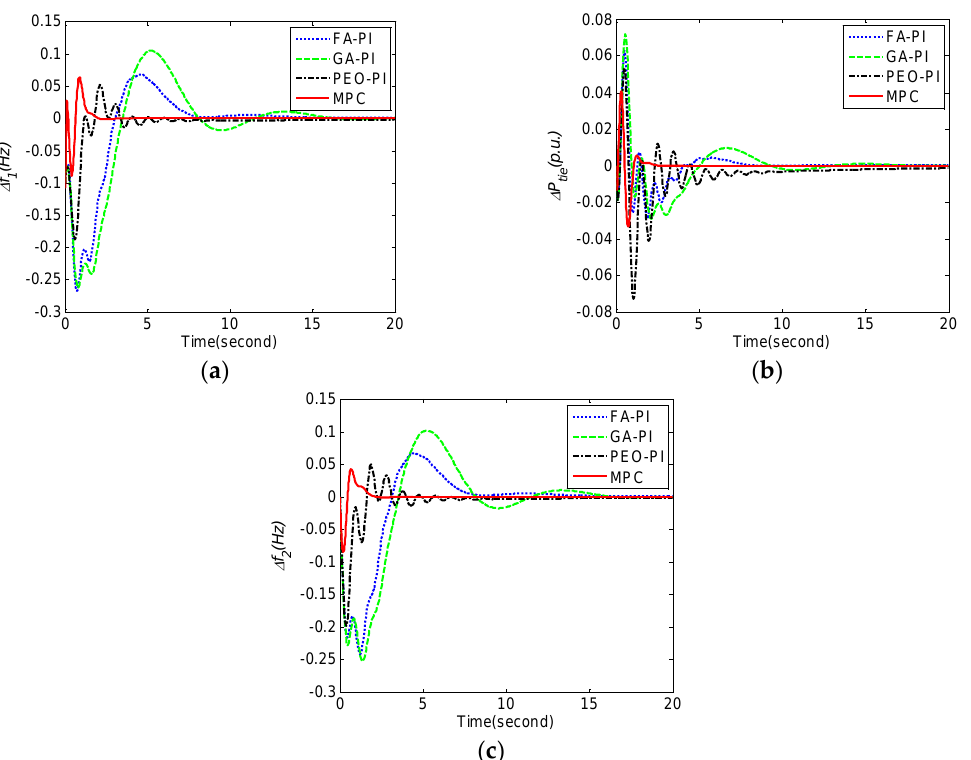
Figure 9. Comparison of frequency deviations ∆ f 1 , ∆ f 2 and tie line power deviation ∆ P tie obtained by different control methods under T t decreasing 40% for case 4. ( a ) frequency deviation ∆ f 1 ; ( b ) frequency deviation ∆ f 2 ; ( c ) tie line power deviation ∆ P tie .